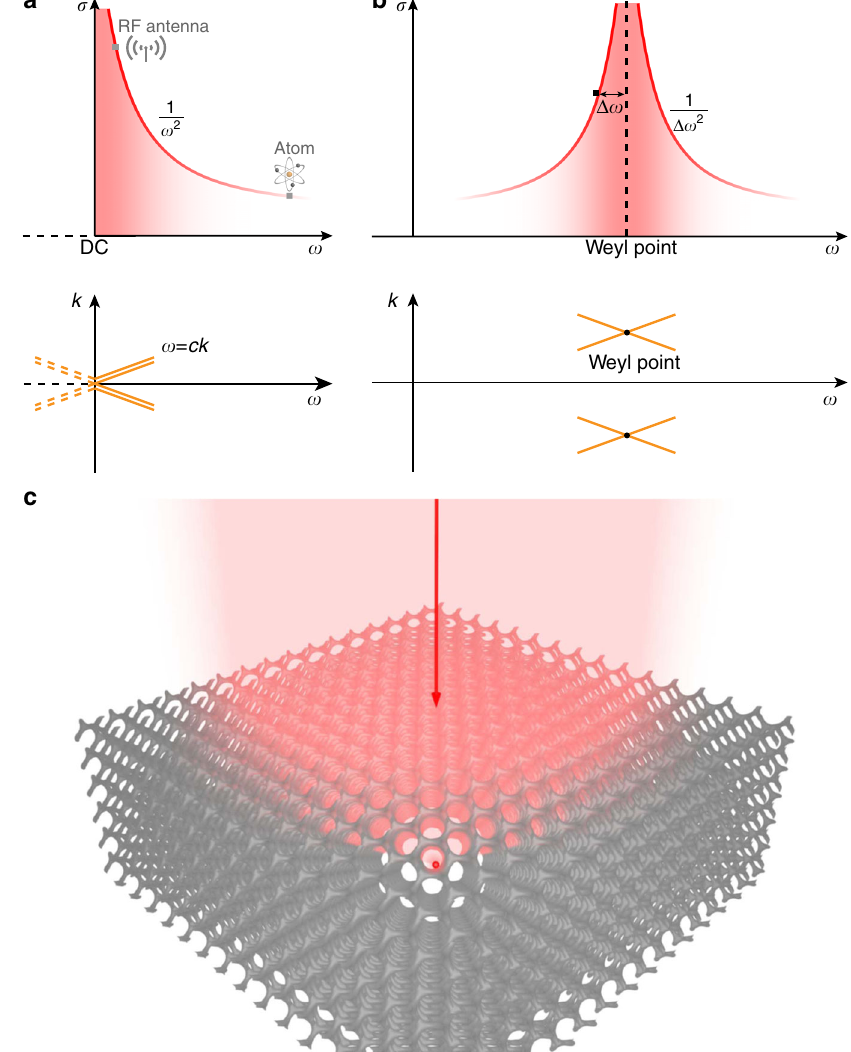
Fig. 1 The length scale of cross section and its relation to dispersion. a In free space, the resonant cross section scales according to σ (cid:2) λ 2 or (cid:2) 1 = ω 2 . Large cross sections always favour low frequencies. For example, the cross section of an optical transition in an atom is small (~10 (cid:3) 12 m 2 ) because of the associated short wavelength (~ μ m). The cross section of an RF antenna is much larger (~10 (cid:3) 4 m 2 ) due to a much longer wavelength (~cm). Diverging cross sections are obtained around the DC point, which happens to be the apex of a conical dispersion. The double lines indicate double degeneracy due to polarization. b By embedding the resonant scatterer in a medium where the dispersion of the continuum exhibits conical dispersions located away from the DC point, diverging cross sections can be realized at high frequencies. The cross section scales according to (cid:2) 1 = Δ ω 2 , where Δ ω is the relative detuning between the resonant frequency of the scatterer and the Weyl point. In both a and b , regions with stronger colour indicate larger resonant scattering cross section. c Schematic of extraordinarily large cross section created by an electrically small resonant scatterer (red dot) placed inside Weyl photonic